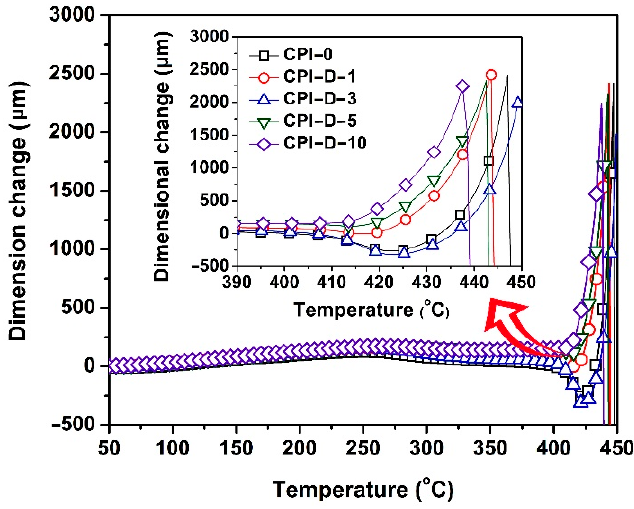
Figure 14. TMA of CPI-0 film and CPI/791 nanocomposite films under nitrogen flow.